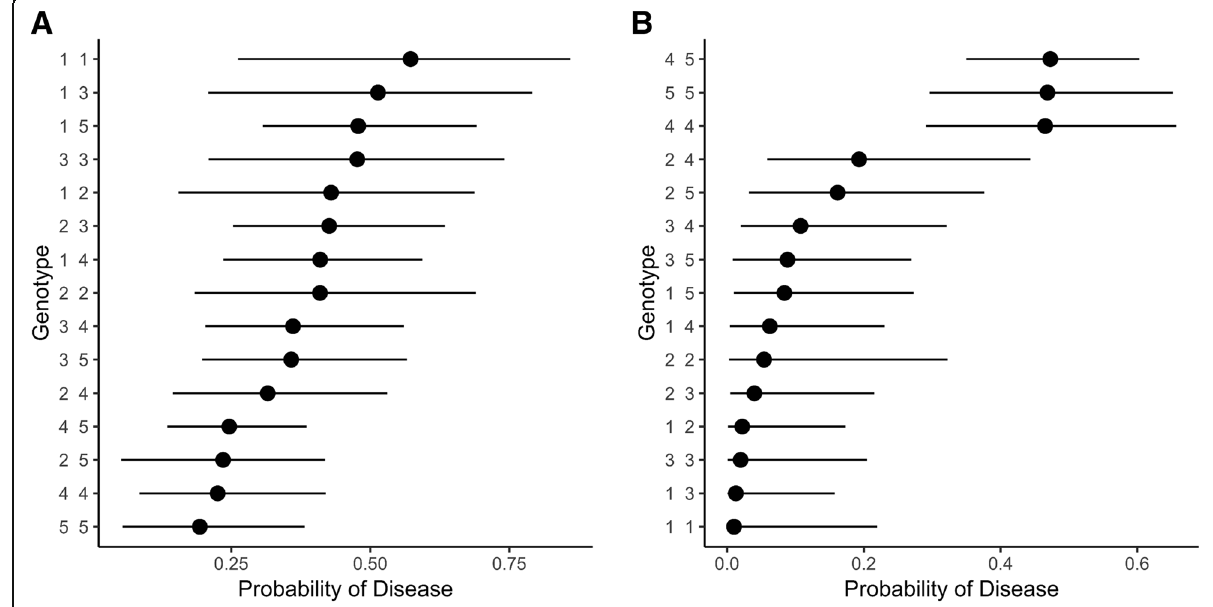
Fig. 1 Probability of ( a ) Addison ’ s disease and ( b ) symmetrical lupoid onychodystrophy associated with the most common genotypic combinations of three-locus haplotypes observed in bearded collies ( n = 219). Dots indicate the estimated probability of disease and lines represent the 95% confidence interval. DLA haplotype codes are as reported in Table